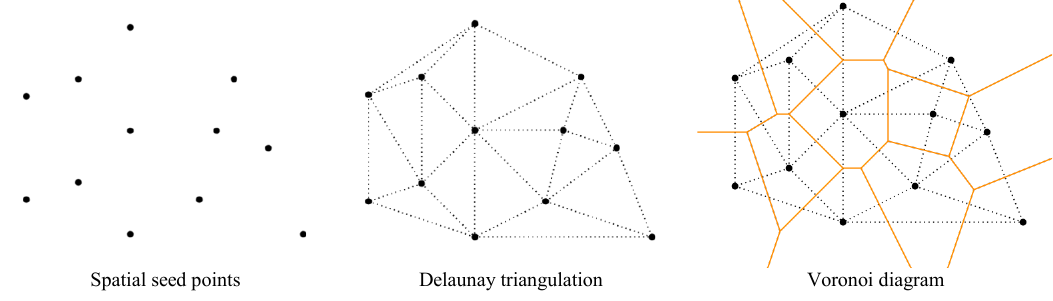
Fig. 3 Typical three steps for generating Voronoi cells by Delaunay triangles.